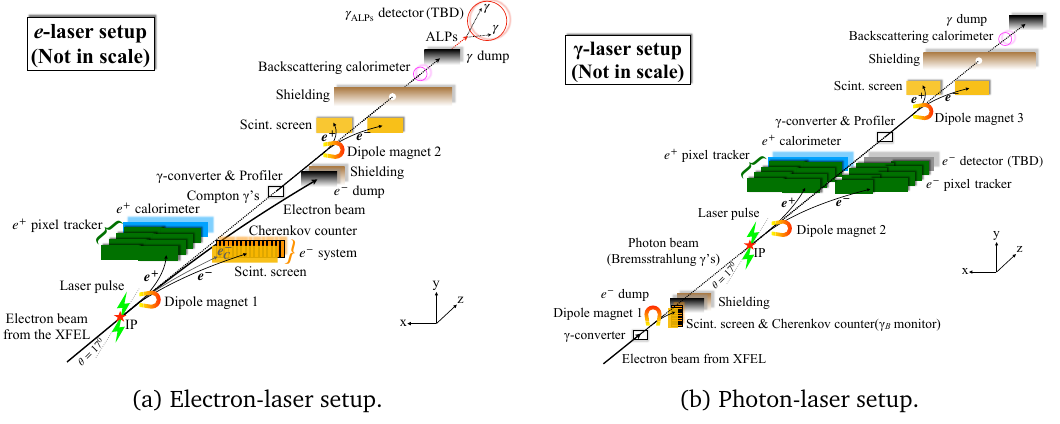
Figure 2: Sketch of the LUXE experimental setups [ 8 ]